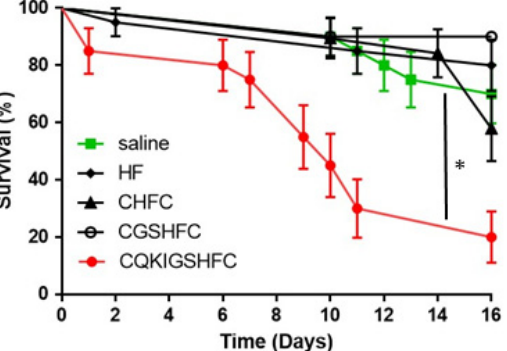
Figure 3. The survival of fire ant workers after injection of the most abundant peptide (CQKIGSHFC) and various short peptides modified from the original epitope. Saline was injected as a control. The asterisk (*) indicates significant differences by Logrank test (CQKIGSHFC ( p = 0.0001). Survival curves were compared using a standard Log-rank test survival analysis. Each replicate was composed of twenty ants, each treatment/control was replicated three times (mean ± 3 s.d). Table 1. The peptides screened from the phage display libraries after 3–4 selection rounds are shown. The library heptapeptides are loop-constrained by a pair of flanking cysteine (C) residues. The most abundant amino acids, G, S, H and F, are in green print.